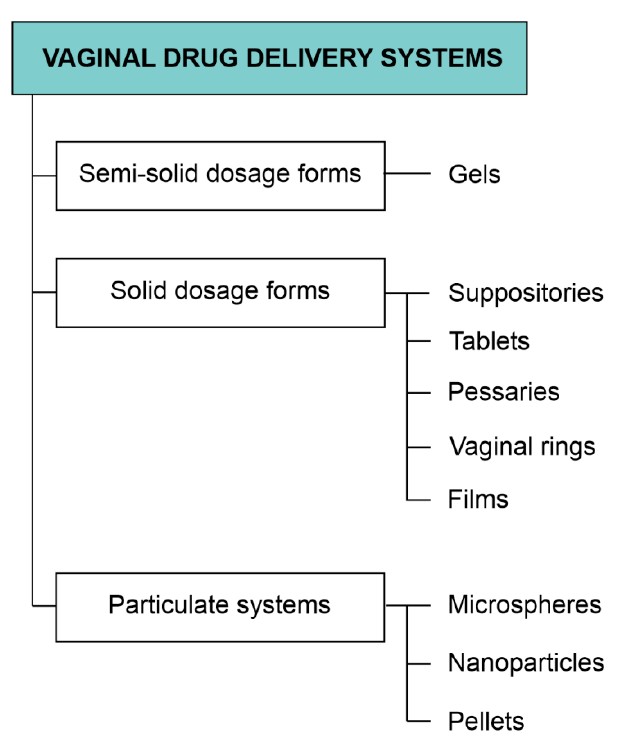
Figure 2. Classification of the most extensively investigated vaginal dosage forms.